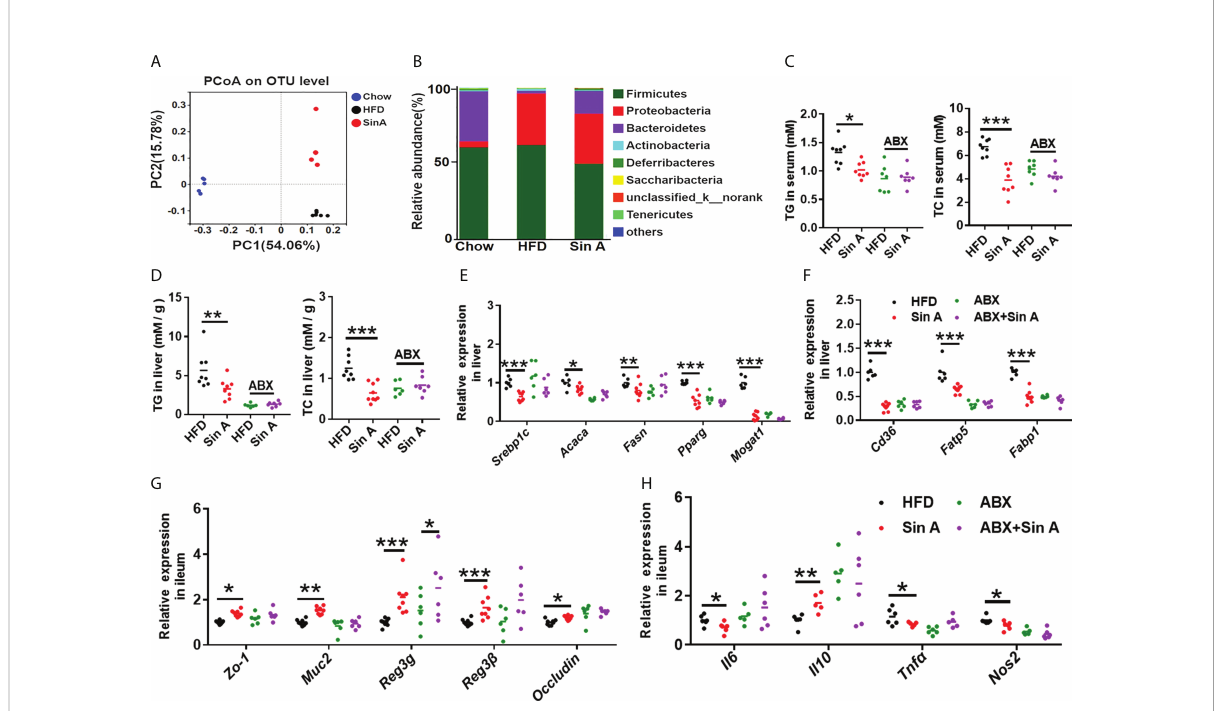
FIGURE 6 Gut microbiota is functional at Sin A-mediated metabolic protection for NAFLD. Mice were randomly divided into four groups ( n =5 – 8). HFD-fed mice were orally treated with vehicle (HFD), Sin A (80 mg/kg, Sin A), antibiotics (ABX), or antibiotics plus Sin A (ABX + Sin A) for 6 weeks. (A) Weighted UniFrac PCoA analysis of gut microbiota based on the OTU data of chow, HFD, and Sin A ( n =5 – 7 per group). (B) Bacterial taxonomic pro fi ling at the phylum level of intestinal bacteria for the above three groups ( n =5 – 7 per group). (C) Changes in TG and TC in serum ( n =7 – 8 per group). (D) Hepatic TG and TC levels ( n =6 – 8 per group). The key gene expression associated with (E) fatty acid biogenesis and (F) fatty acid uptake ( n =5 – 8 per group). Results of gene expression associated with (G) ileum tight junction molecules and (H) in fl ammation response ( n =5 – 8 per group). Values are expressed as means ± SD. Statistical signi fi cance was determined by two-way ANOVA for the multiple-group comparisons. p *<0.05; ** p <0.01; *** p <0.001. PcoA, principle coordinates analysis; ABX, antibiotics; TG, triglyceride; TC, total cholesterol; Srebp-1c, sterol regulatory element binding protein-1c; Acaca, acetyl-CoA carboxylases alpha; Fasn, fatty acid synthase; Mogat1, Monoacylglycerol O-acyltransferase 1; Pparg, peroxisome proliferative activated receptor, gamma; Scd-1, stearoyl-coenzyme A desaturase-1; Cd36, cluster of differentiation 36; Fatp5, fatty acid transport protein 5; Fabp1, fatty acid-binding protein1; Zo-1, zonula occludens-1; Muc2, mucin2; Reg3g, Regenerating islet-derived protein 3 gamma; Reg3 b , Regenerating islet-derived protein 3 beta; Il6, interleukin 6; Il10, interleukin10; Tnfa, tumor necrosis factor a ; Nos2, Nitric Oxide